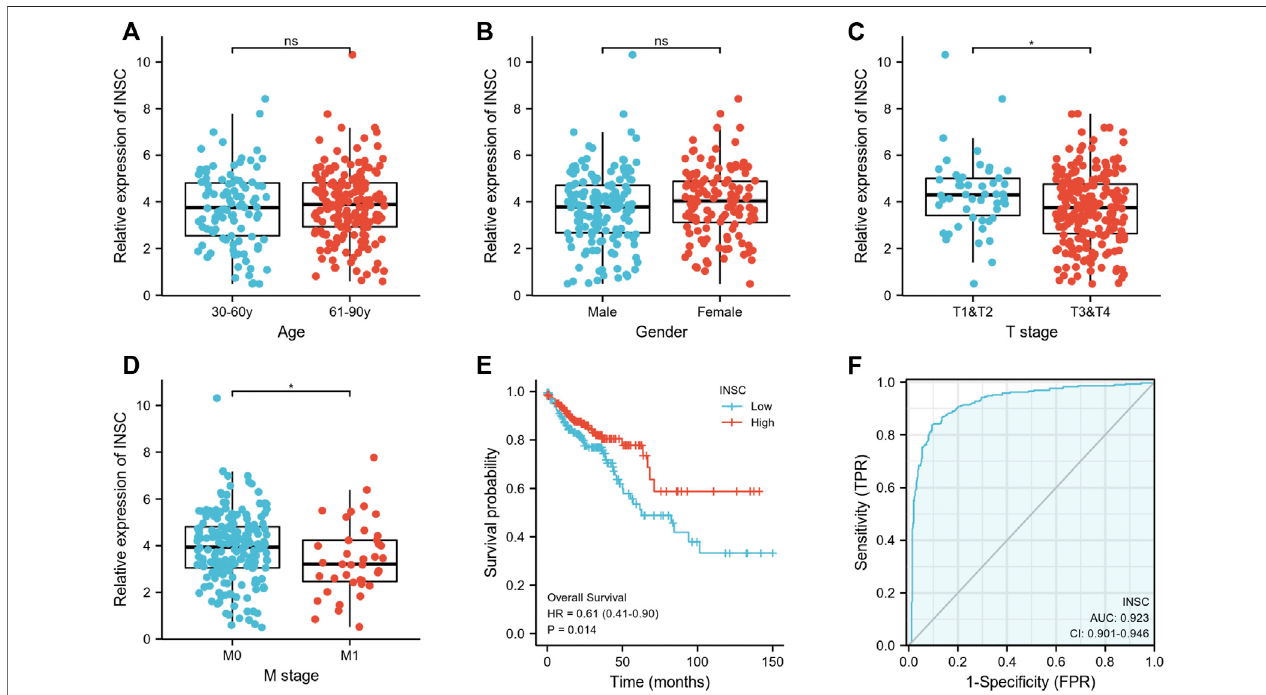
FIGURE 3 | (A,B) Association between INSC expression and clinical features such as age and gender in COAD. (C,D) The association between INSC expression andclinicalfeaturessuchasTandMstagesinCOAD.LowerINSCexpressionwasrelatedtohigherTandMstages(* p < 0.05). (E) TheKMsurvivalcurvedisplayedalow level of INSC with a poor prognosis for COAD patients. (F) ROC analysis illustrated that INSC was an accurate marker to distinguish tumor from normal tissue. The AUC was